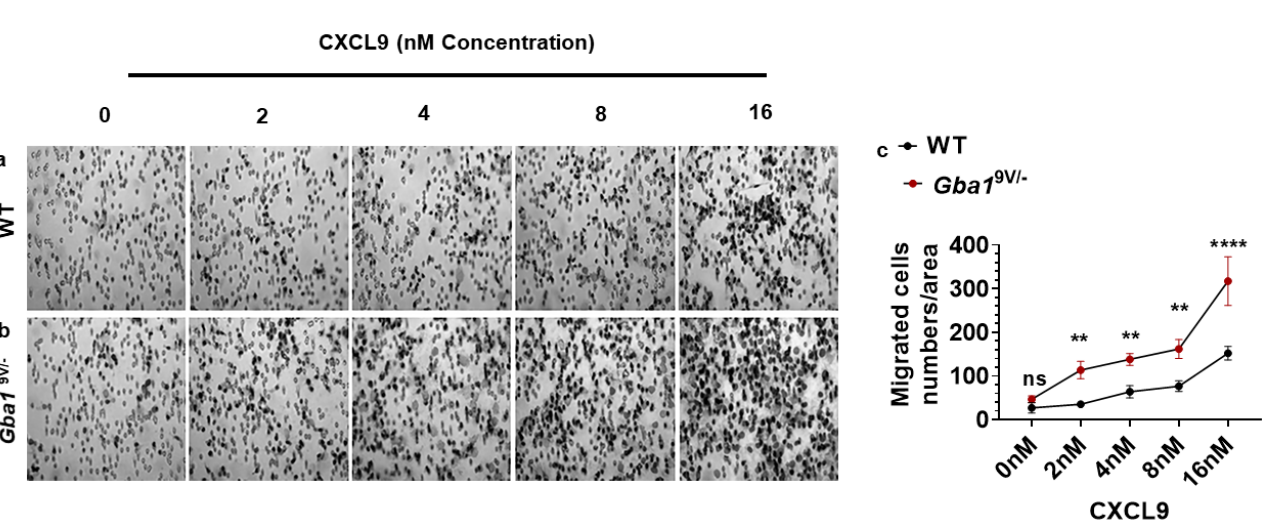
Figure 2. CXCR3 surface expression in pulmonary T cell subsets from Gba1 9V/- mice. CXCR3 expression in FACS-sorted CD3 + CD4 + T cells ( a – d ) and CD3 + CD8 + T cells ( e – h ) from lung of strain-matched Gba1 9V/- and WT mice ( n = 5/group). δ MFI: CXCR3 MFI—isotype MFI. In the dot plots of isotypes and specific antibodies ( a , e ), in the histograms of isotypes ( b , f ), specific antibodies ( c , g ), and the bar diagrams ( d , h ), the black lines/columns correspond to WT and the maroon lines/columns to Gba1 9V/- mice. Values in d and h are the means ± SD. and asterisks show significant differences between WT and Gba1 9V/- mice (**** p < 0.0001). Three independent experiments were conducted, and groups were compared using student’s t -tests.